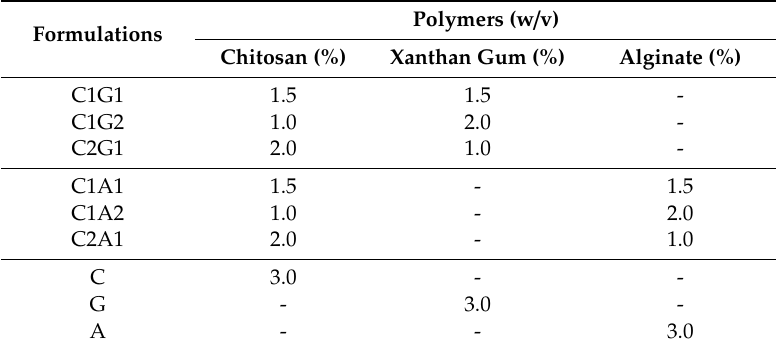
Figure 2. Flowchart of “Onion-like” process to obtain polyelectrolyte complex superabsorbent hydrogels (SAHs). Table 1. Formulation of polyelectrolytes